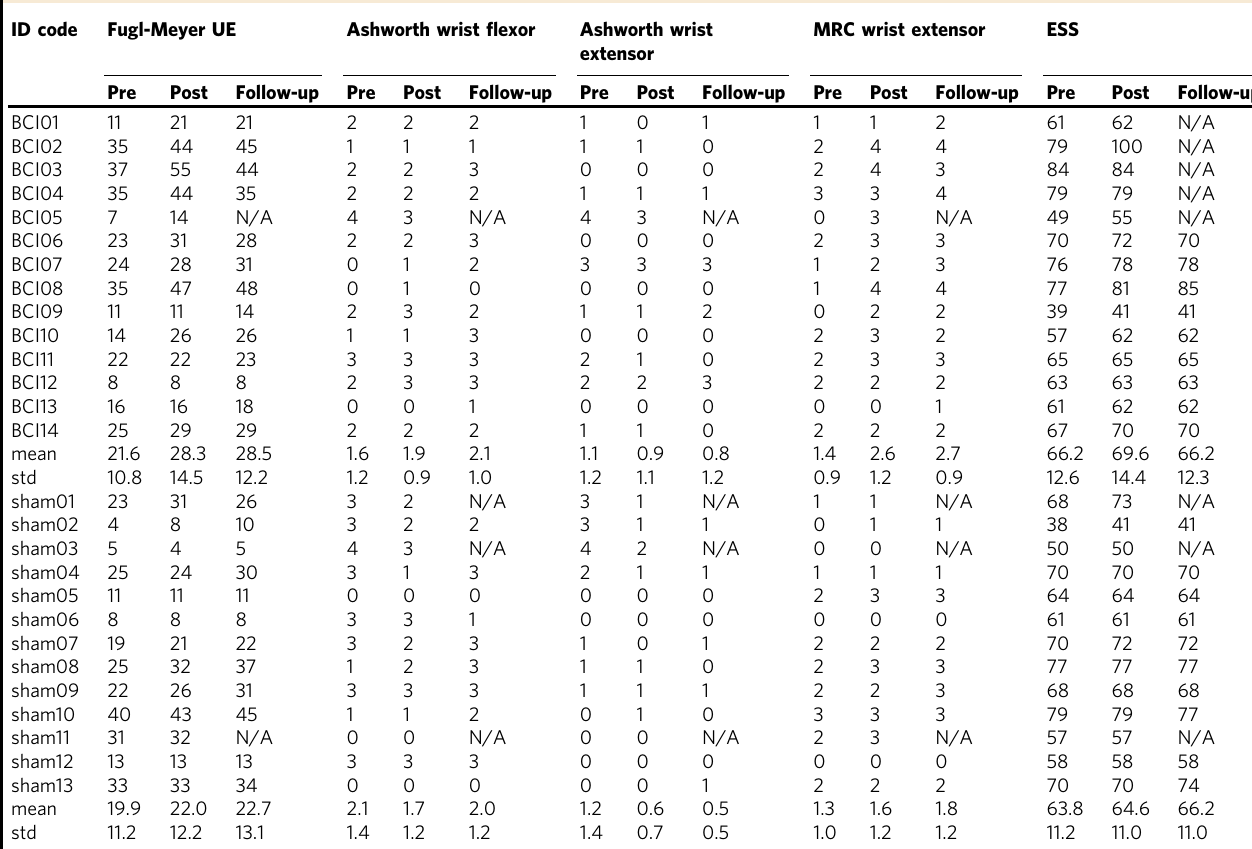
Table 1 Clinical scores for all